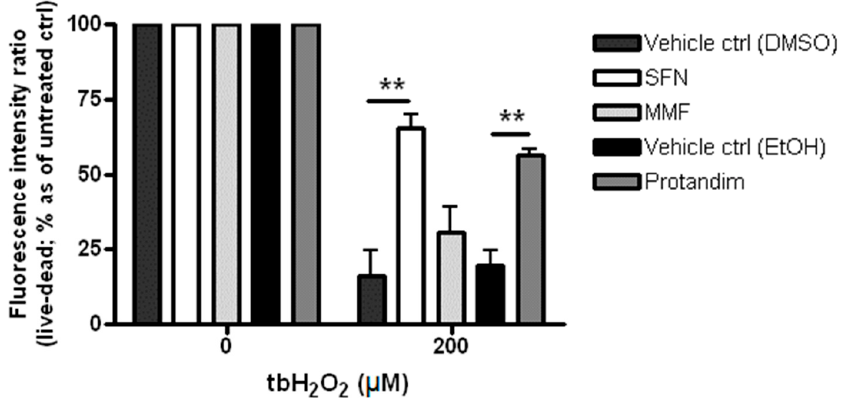
Figure 2. Sulforaphane and Protandim promote viability of OLN-93 cells under tert-butyl hydrogen peroxide-induced oxidative insult. OLN-93 cells were treated with 5 µ M SFN, 90 µ M MMF, 60 µ g/mL Protandim or their respective DMSO or EtOH vehicle control for 24 h. After removal of medium, cells were subsequently exposed to either control medium or medium with 200 µ M tert-butyl hydrogen peroxide. Cell viability was measured using an Invitrogen live/dead cytotoxicity kit. Data are presented as percentage of control and expressed as the mean ± SEM of 3 independent experiments. Statistics reflect one-way ANOVA test with post hoc Bonferroni correction; ** p < 0.01.